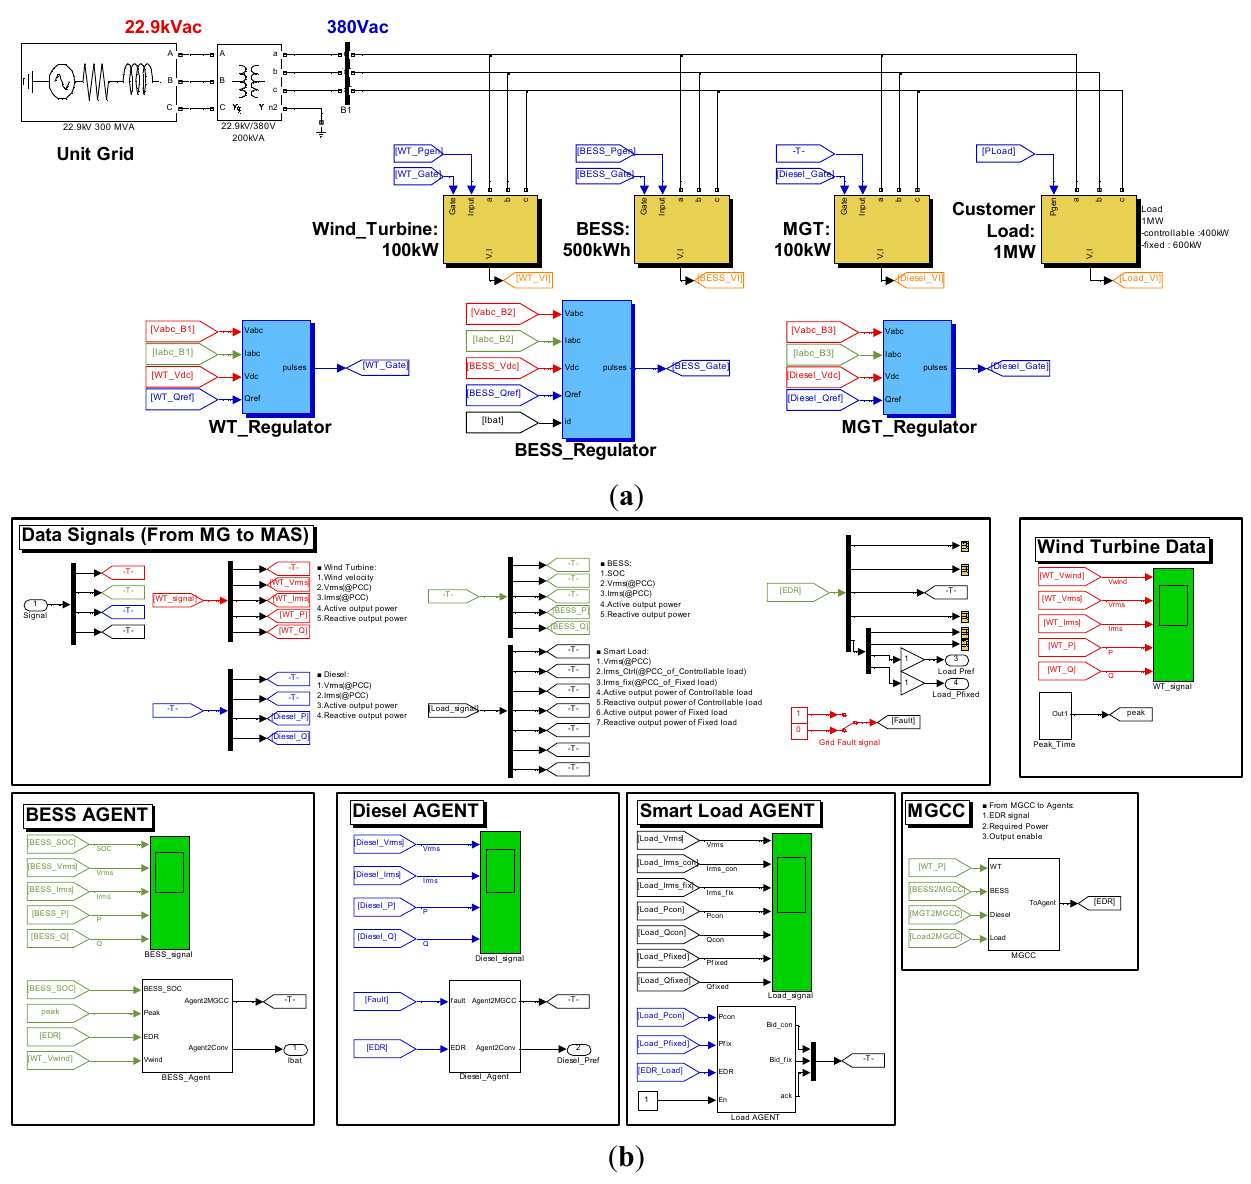
Figure 12. MATLAB/Simulink Simulation model: ( a ) Microgrid simulation model; ( b ) EMS simulation